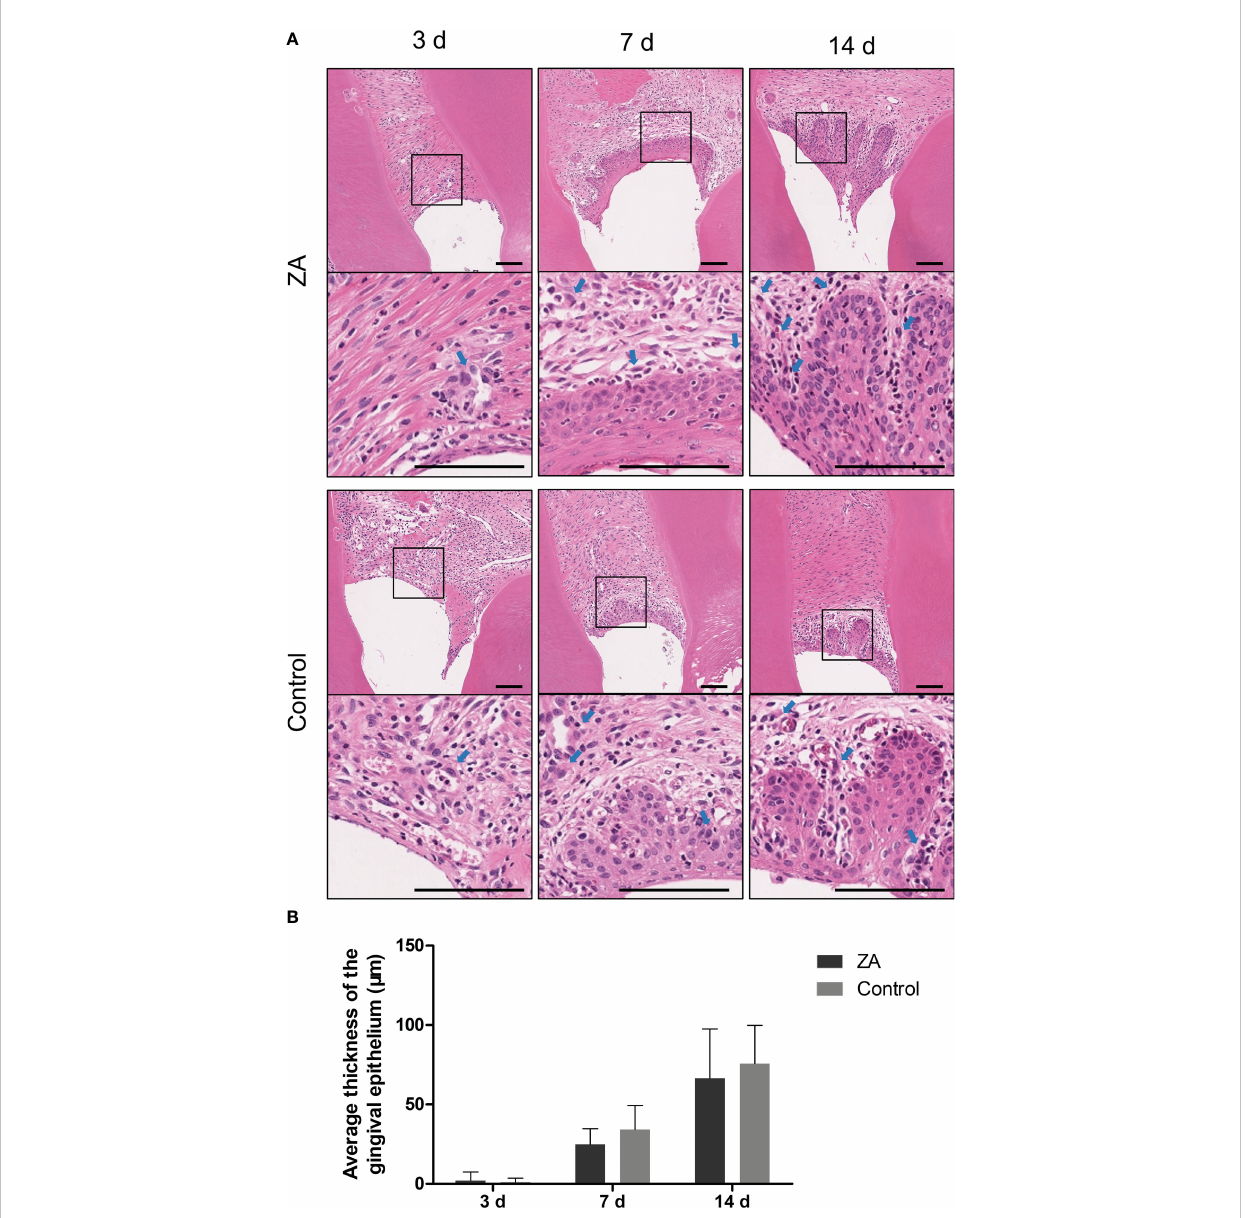
FIGURE 5 Result of histology staining of the ZA group and the control group. (A) Representative histology staining images of the ZA group and the control group. The images in the second panel of each group are enlarged views of the boxed areas in the above images. Blue arrows indicated